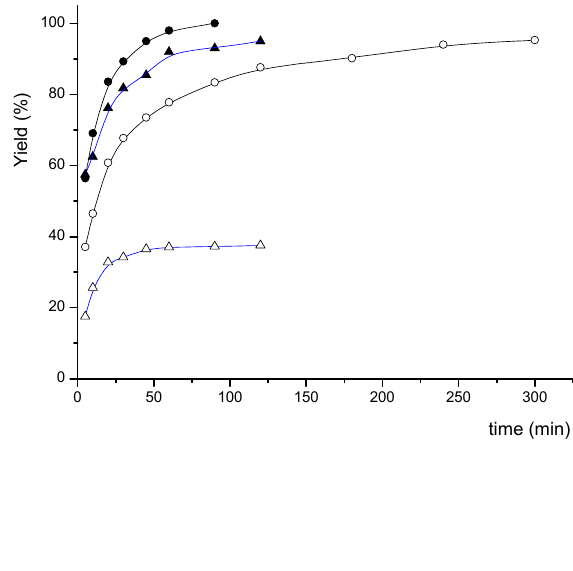
Figure 4. Reaction profiles for Suzuki-Miyaura reaction of 4-methylphenyl bromide catalyzed by Pd/ 7a 0.05 mol% ( ● ), 0.005 mol% ( ○ ), and phenyl bromide catalyzed